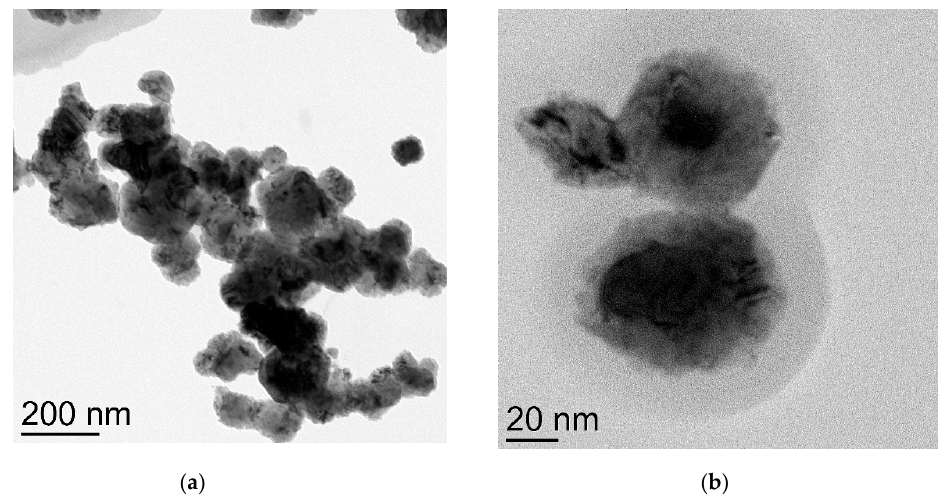
Figure 3. TEM images of CuNPs of the average particles size 86 nm: ( a ) general view of the spatial organization of nanoparticles; ( b ) image of the single nanoparticle (black) covered with the oxide phase (grey).